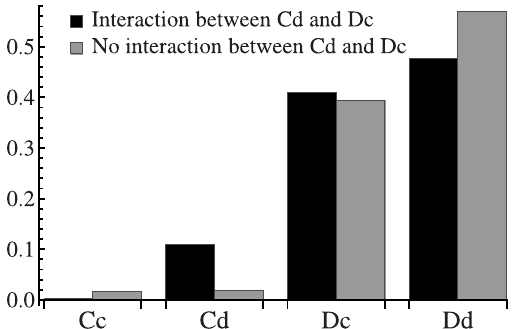
Figure 8. Illustration of the effect of roles reciprocity of Cd and Dc with p ~ 0 : 1 . Without the interaction between Cd and Dc , their average fractions descend obviously.